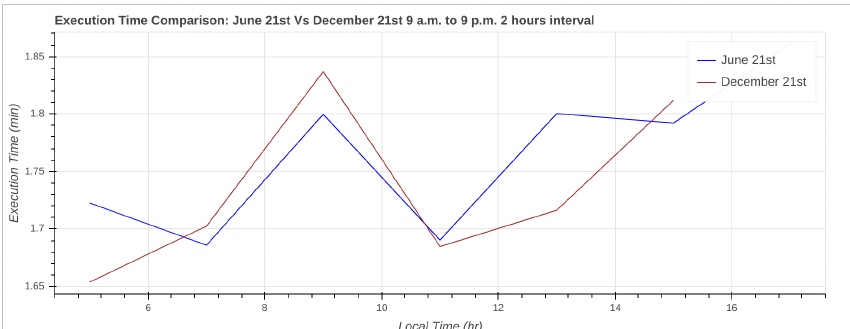
Figure 13. Shadow map for 21 December 2020 from 9 a.m. to 7 p.m. 2 h interval.